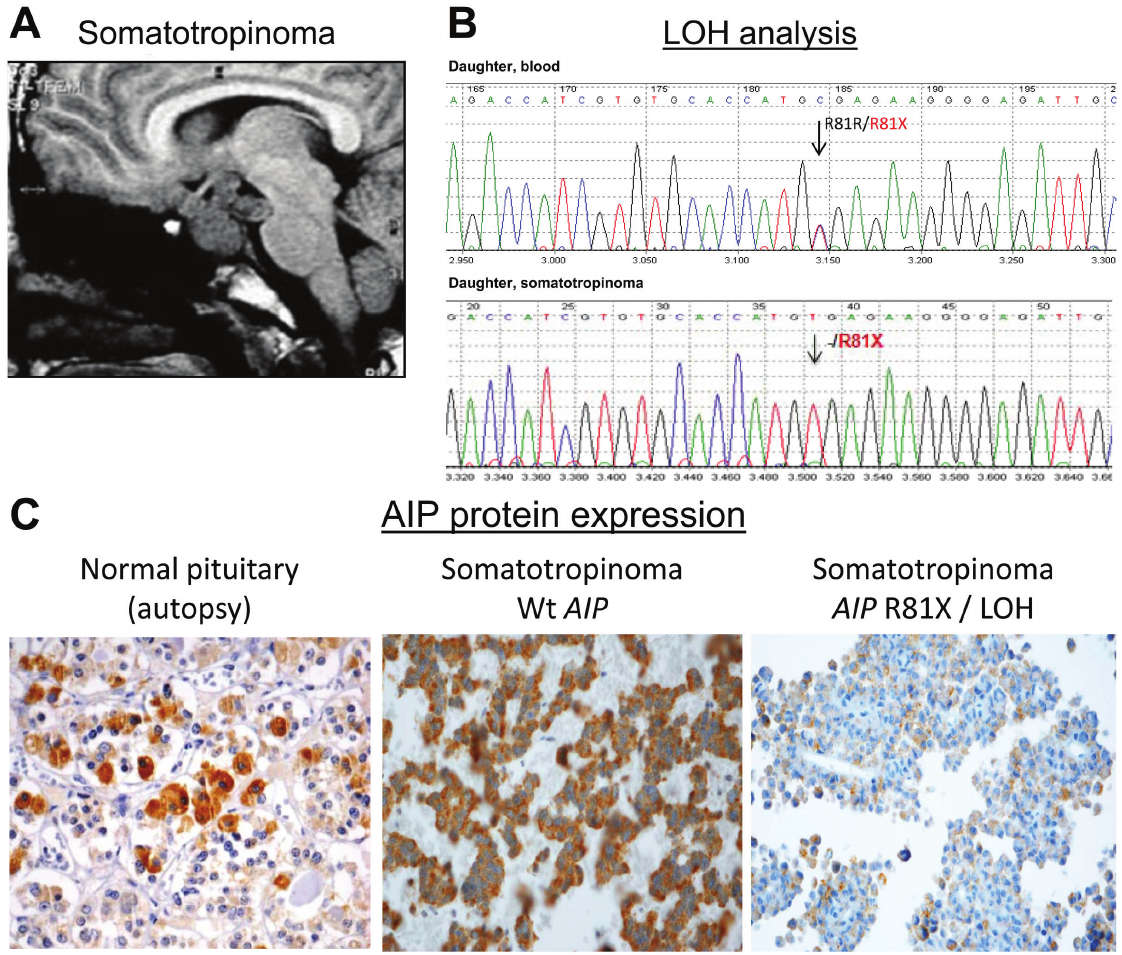
Figure 2 - Loss of AIP in the familial somatotropinoma. A - The MRI of the index patient’s daughter revealed a large and invasive pituitary adenoma (so- matotropinoma) that was resistant to treatment with a somatostatin analog. She inherited the heterozygous R81X AIP germline mutation (Fig. 1B) from the index case. B - The sequence analysis of AIP in tumoral DNA samples revealed that only the R81X-mutated allele (t) was present in the somatotropinoma, indicating somatic loss and inactivation of wild-type AIP . C - The immunohistochemical analysis showed AIP protein expression in the normal pituitary and a GH-secreting pituitary adenoma of a patient with sporadic acromegaly without AIP mutation. The somatotropinoma of the patient harboring the R81X germline mutation and the somatic loss of the gene presented low AIP protein